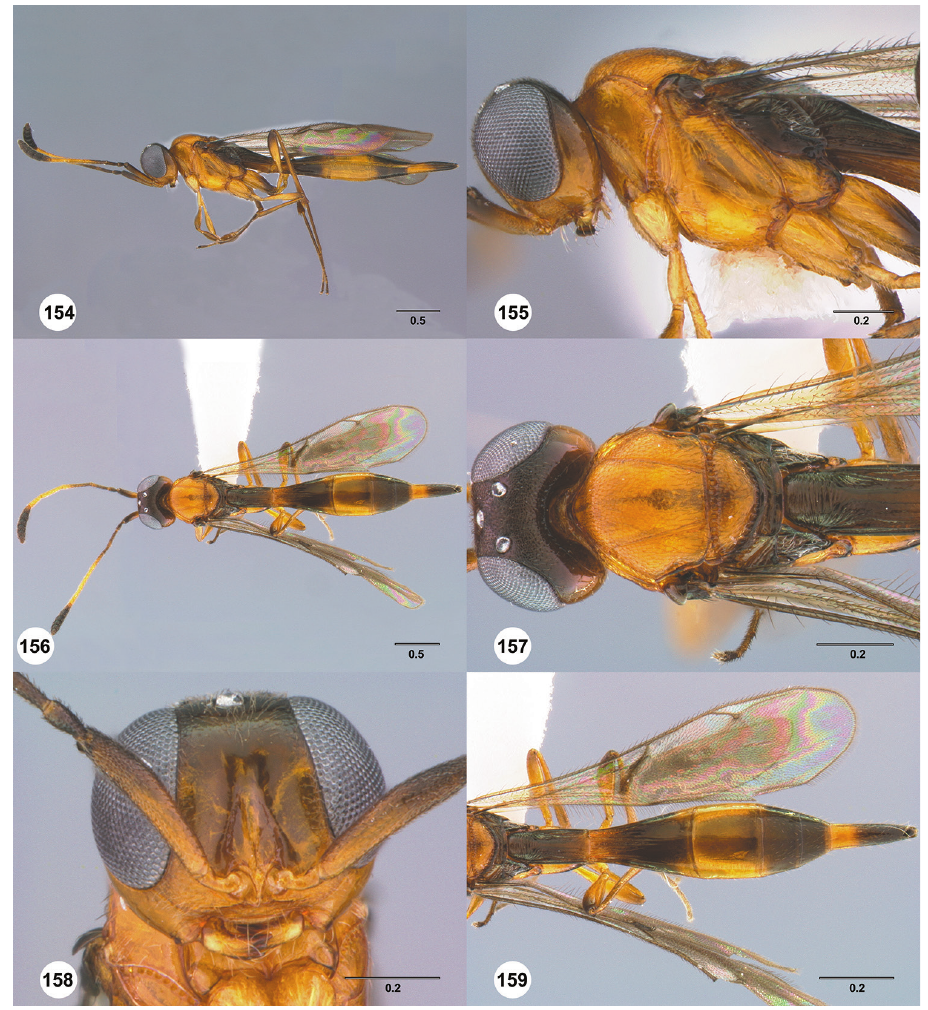
Figures 154–159. Calliscelio longius sp. n., female, holotype (OSUC 374730). 154 Lateral habi- tus 155 Head and mesosoma, lateral view 156 Dorsal habitus 157 Head and mesosoma, dorsal view 158 Head, anterior view 159 Metasoma, dorsal view. Scale bars in millimeters. Color of fore wing: hyaline. Rs+M: nebulose, strongly pigmented. Setae on R: long, erect, surpassing the margin of the wing. Length of R: distinctly longer than r-rs. Length of R1: greater than 3.0× length of r-rs. Color of metasoma in female: dark brown; orange throughout; variably orange to black. Color of metasoma in male: brown throughout; variably yellow to pale brown; black throughout. Horn on T1 in female: large and distinct. Sculpture of T1 horn dorsally: transversely striate; smooth to somewhat transversely striate. Sculpture of posterior margin of T1 in female: longitudinally striate throughout. Sculpture of